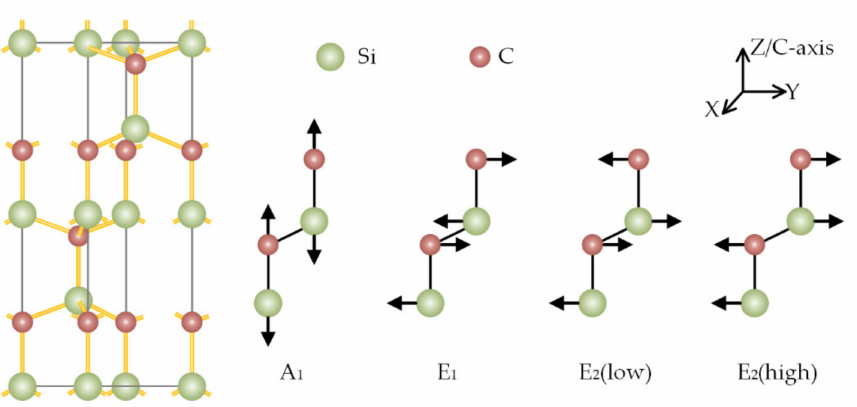
Figure 1. Atomic displacements of the Raman active modes in